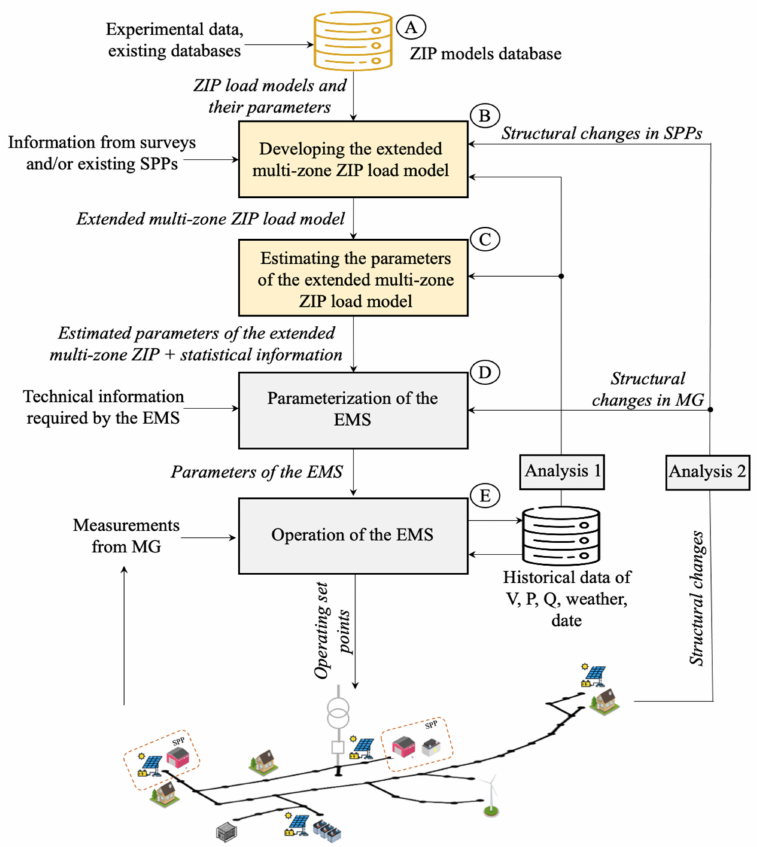
Figure 2. Overview of the proposed